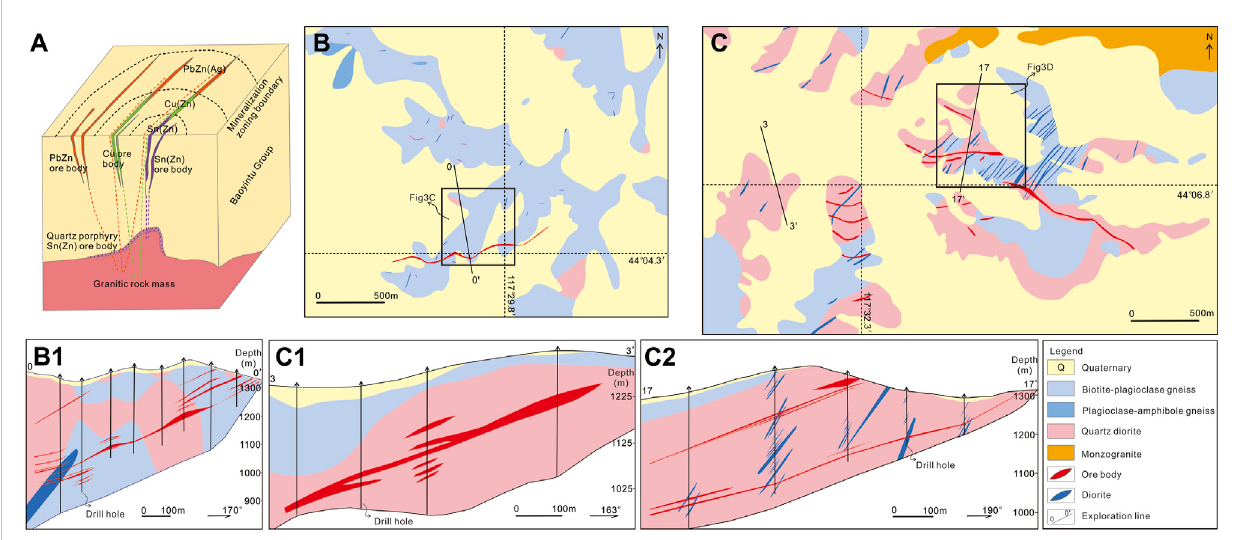
FIGURE 2 (A) Thesimpli fi edmetallogenicmodeloftypicalpolymetallicdeposits(modi fi edafterGuo,2016). (B) and (B1) Thegeologicalmapandcross-section map of 0-0 ′ exploration line of the Weilasituo Cu-Zn deposit (modi fi ed after Liu et al. (2016); IMGECL (2018)). (C) , (C1) and (C2) The geological map and cross-section map of 3-3 ′ and 17-17 ′ exploration line of the Bairendaba Ag-Pb-Zn deposit (modi fi ed after Xi et al. (2014); Liu et al. (2016)).